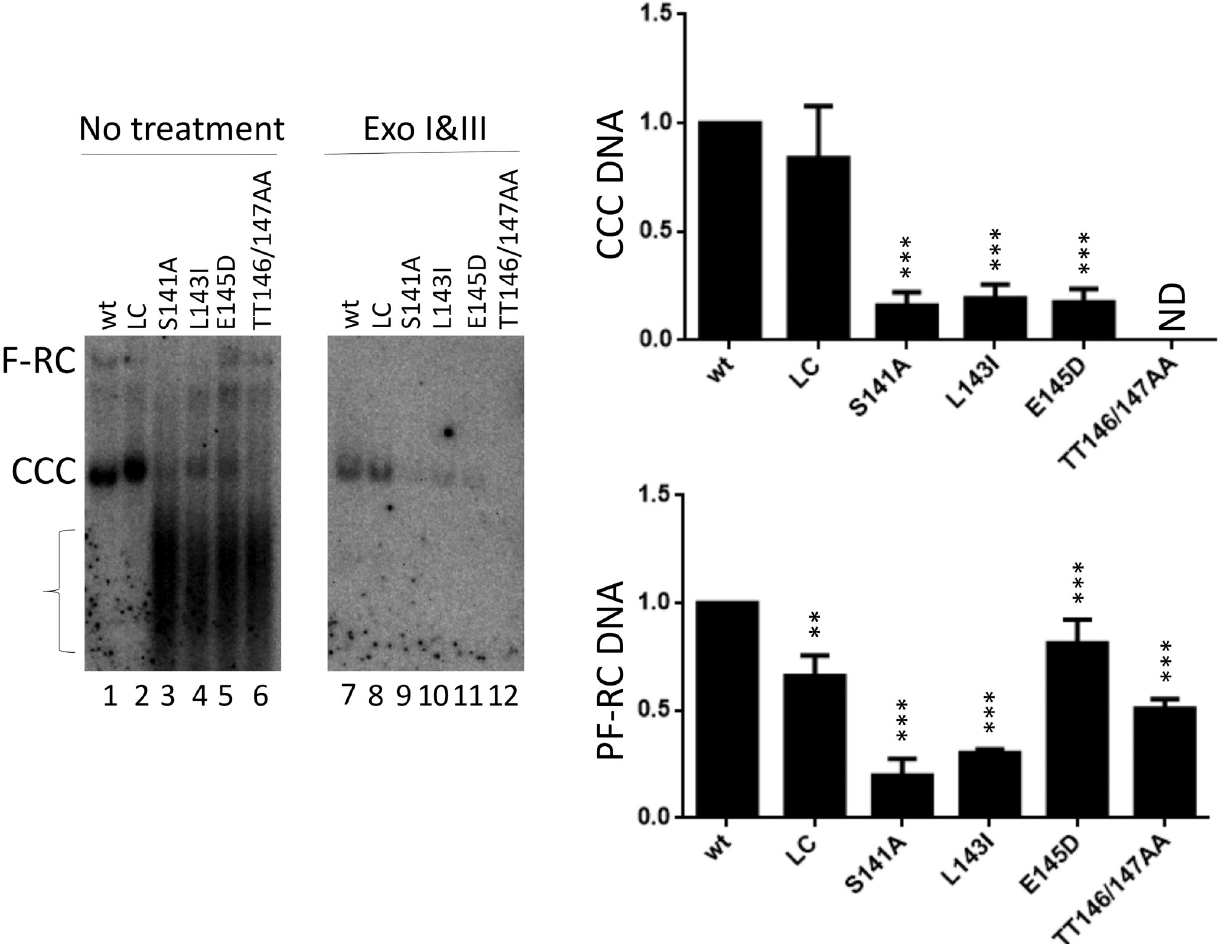
Fig 9. Effect of linker mutations on infection. HBV inocula were prepared from HepG2 cells co-transfected with the HBc-expression construct plus the HBc-defective replicon as shown in Fig 6, and used to infect HepG2-NTCP cells. PF DNA was extracted three days post-transfection and analyzed by Southern blot analysis, with (lane 1–6) or without (lane 7–12) pretreatment with exonuclease I and III (Exo I&III). Quantitative results are shown in the graphs to the right. The small m. w. DNA smear present in certain linker mutants (lane 3–6) is indicated by the bracket. PF-RC, PF-RC DNA; CCC, CCC DNA; ND, not detected. �� , P < 0.01; ��� , P <